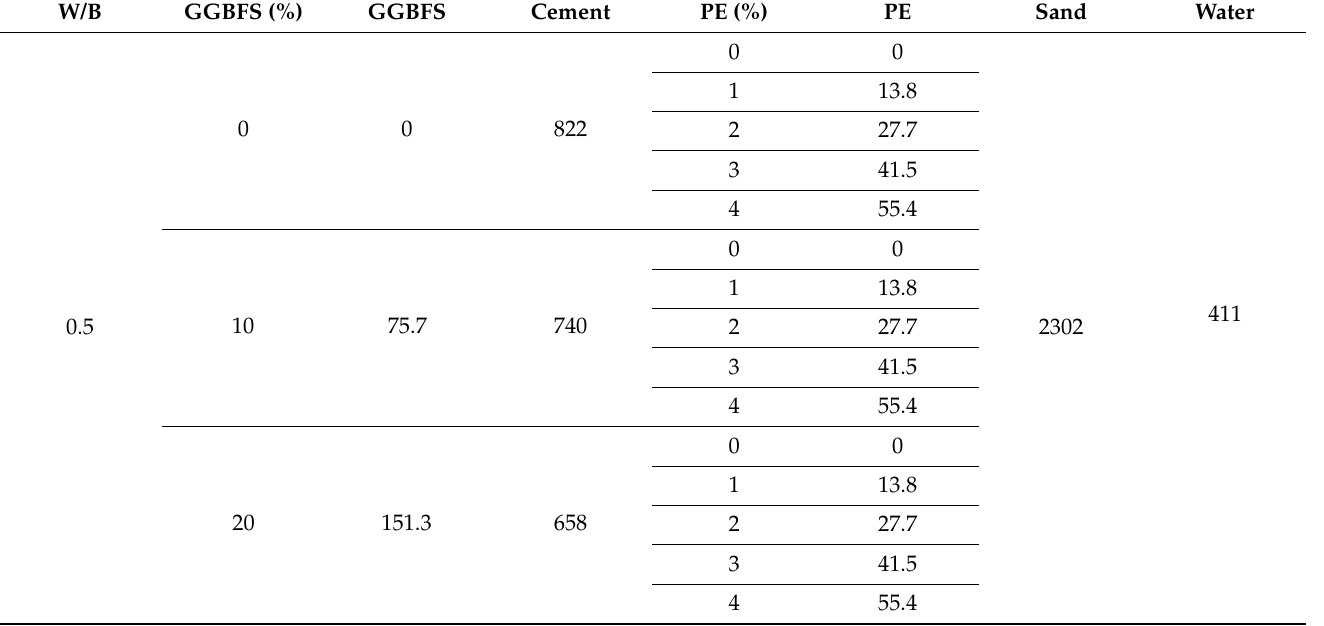
Table 2. Mixture proportions of cement mortars (unit: kg/m 3